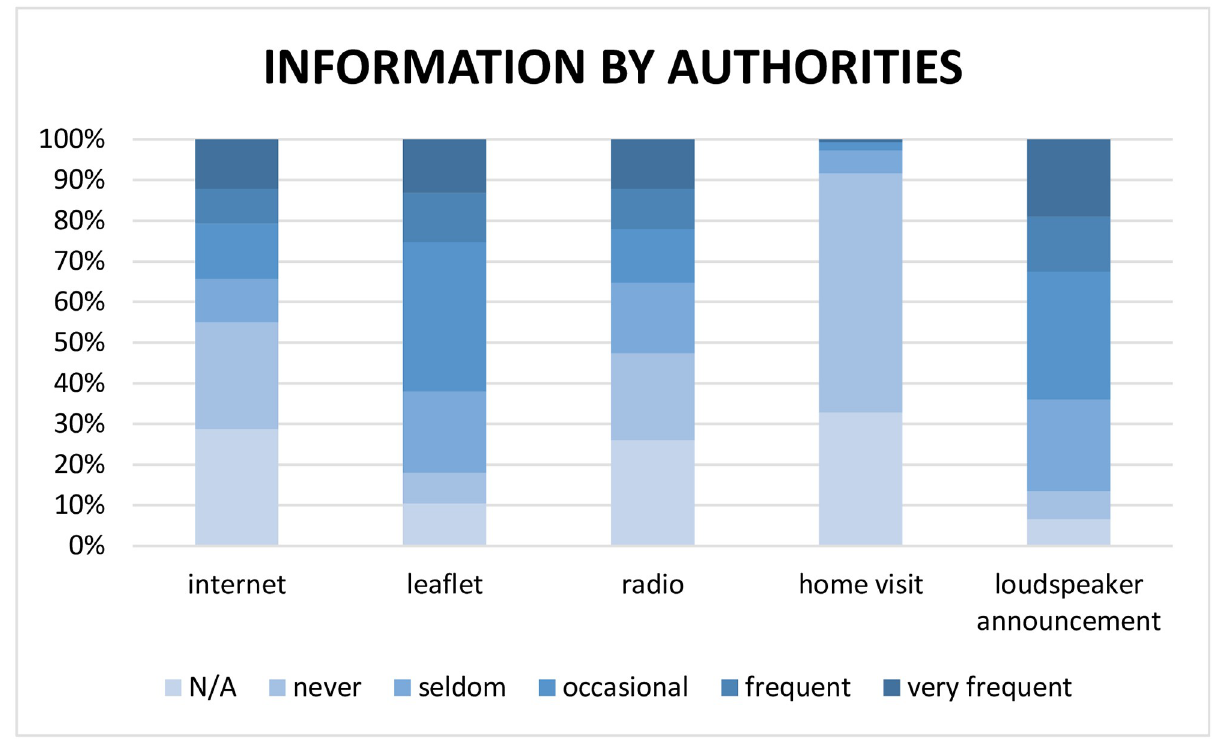
Fig 3. Distribution of information by the local